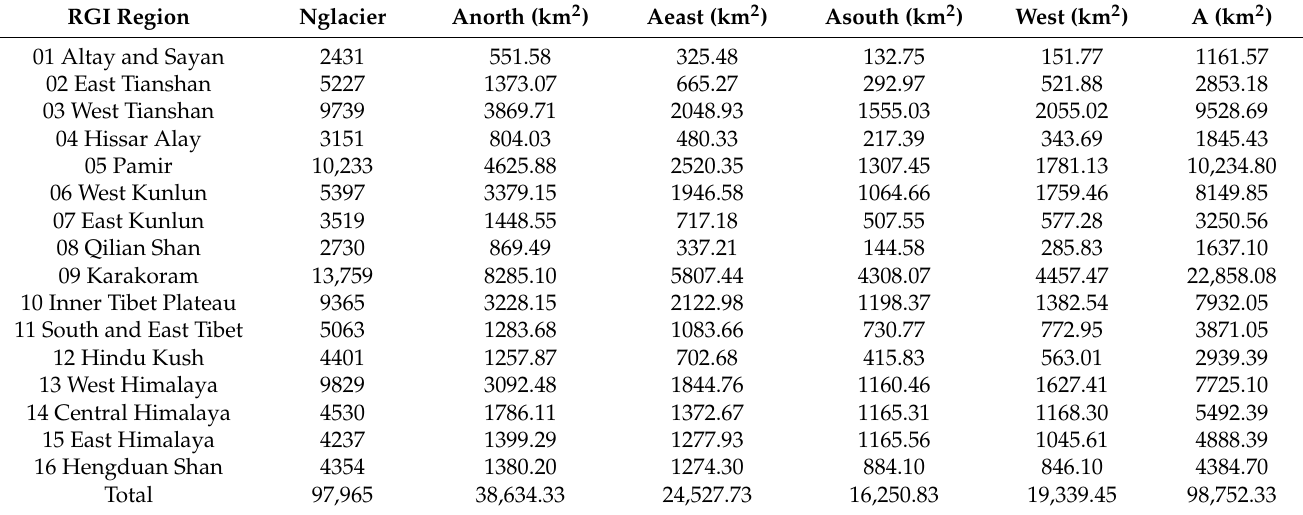
Table 1. Summary of the glacier characteristics statistics for different regions within